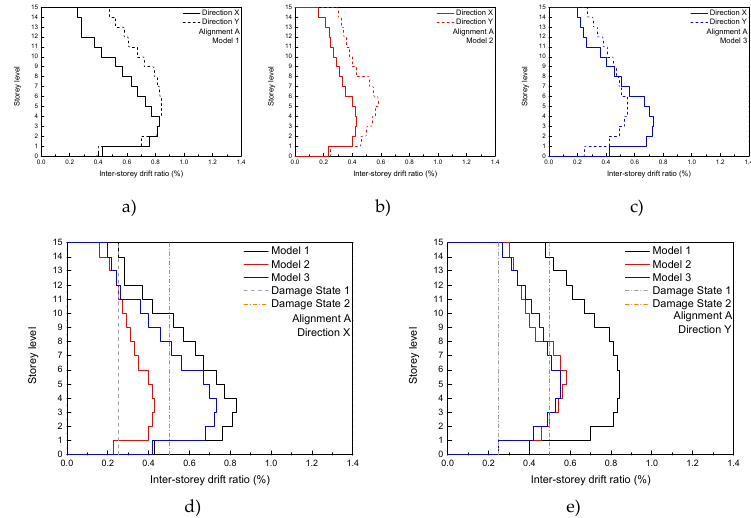
Figure 17. Linear elastic dynamic analysis result: maximum inter-storey drift ration (alignment A) ( a ) Model 1; ( b ) Model 2; ( c ) Model 3; ( d ) global comparison (Direction X); and ( e ) global comparison (direction Y).